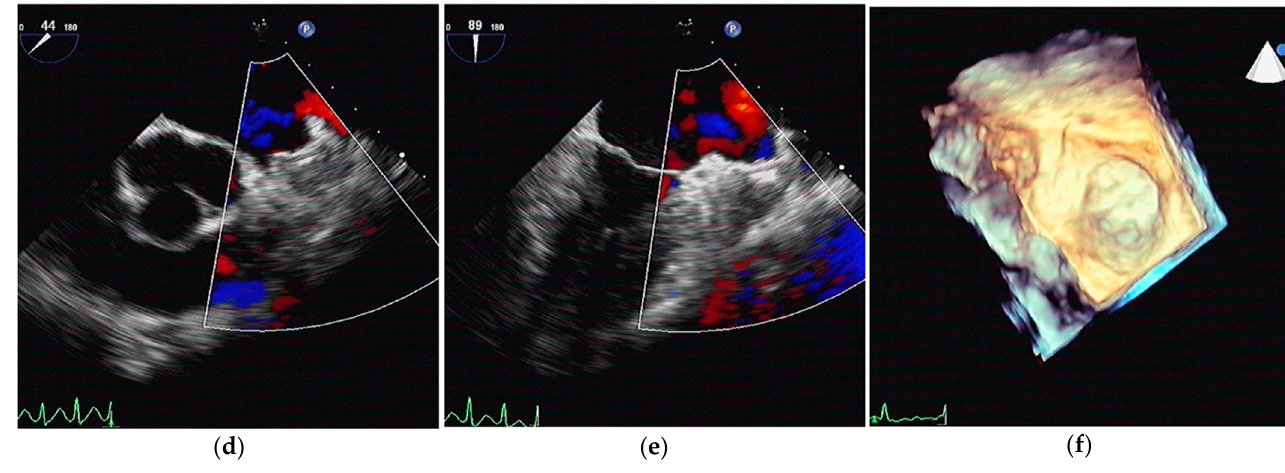
Figure 1. The LA CA procedure (index and redo) and TEE follow-up in a patient with an implanted LAAO device. ( a ) Fluoroscopic image showed the position of Watchman device (white arrow), coronary sinus catheter (green arrow), circular mapping catheter (yellow arrow) and ablation catheter (red arrow); ( b ) during the index procedure for paroxysmal AF, CPVI was successfully performed; ( c ) during the redo procedure for AFL, the ridge between the LAA and left superior PV were targeted (red dots) to restore sinus rhythm; ( d – f ) TEE follow-up after LA CA showed no device dislodgement, PDL, or DRT. AF—atrial fibrillation; AFL—atrial flutter; CA—catheter ablation; CPVI— circumferential pulmonary vein isolation; DRT—device-related thrombus; LA—left atrium; LAAO—left atrial appendage occlusion; PDL—peridevice leakage; PV—pulmonary vein. After a median follow-up period of 793 (376, 1090) days, four patients (22%) expe-